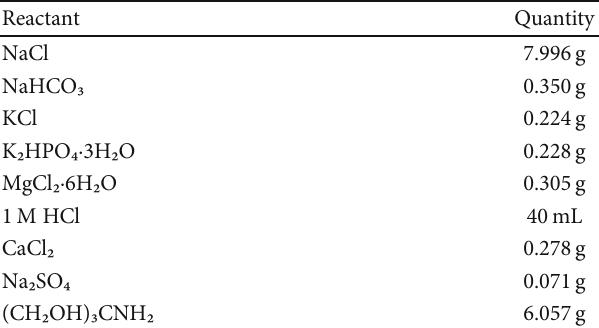
Table 1: Reactants used for the SBF preparation.